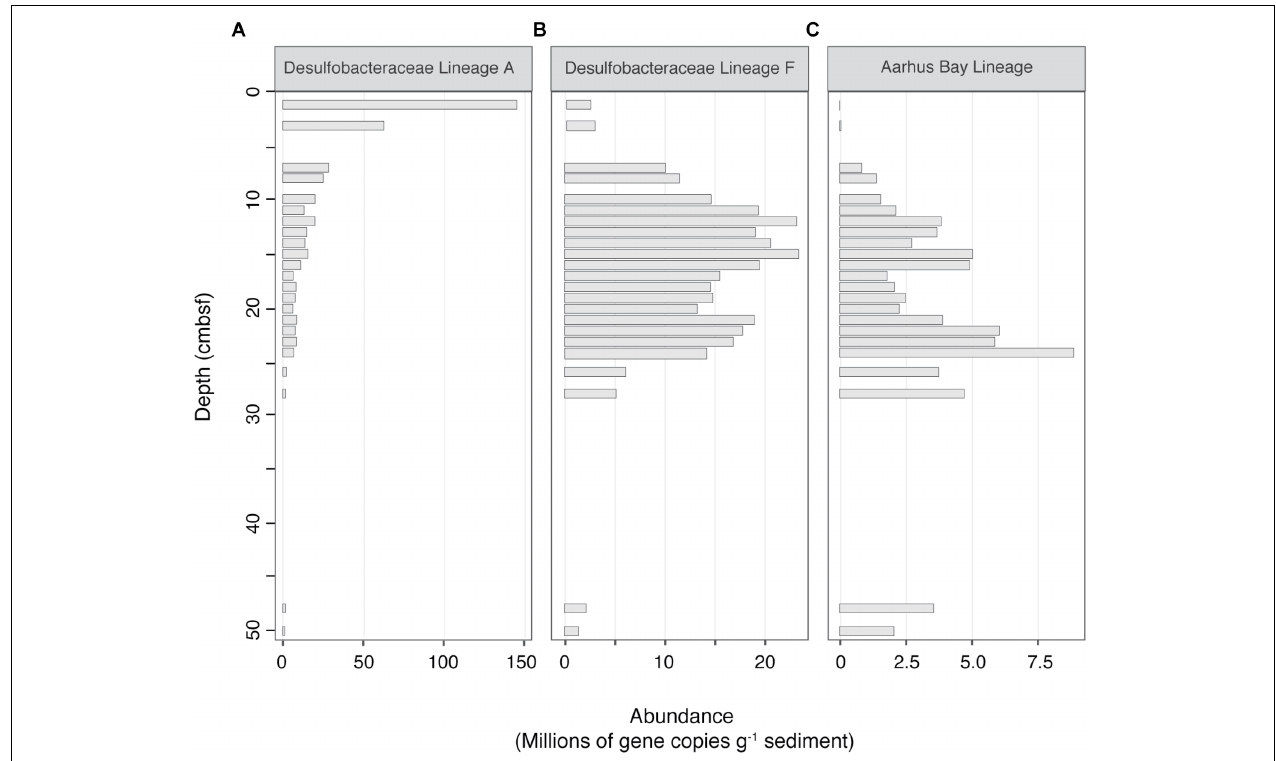
FIGURE 5 | Absolute abundance profiles of three selected SRM lineages, representing three prominent population trends with depth. (A) Desulfobacteraceae Lineage A, declining with depth (B) Desulfobacteraceae Lineage F, clear maximum in the SR zone (C) Aarhus Bay Lineage, increasing with depth. Absolute abundances were estimated by multiplying sequence percent abundances by dsrB gene copy numbers, as determined by qPCR. Blank spaces indicate a lack of sequencing